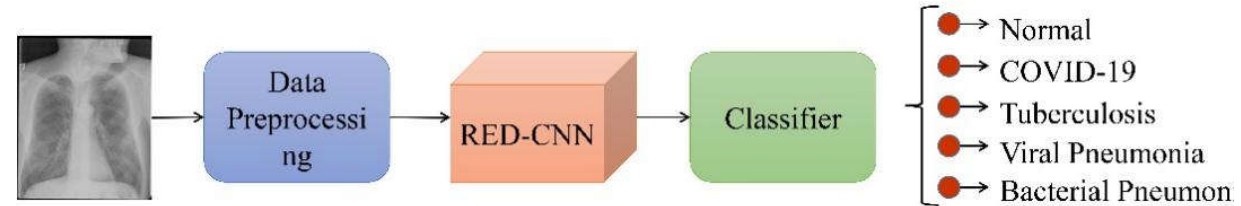
Figure 1. The multi-classification pulmonary disease model.